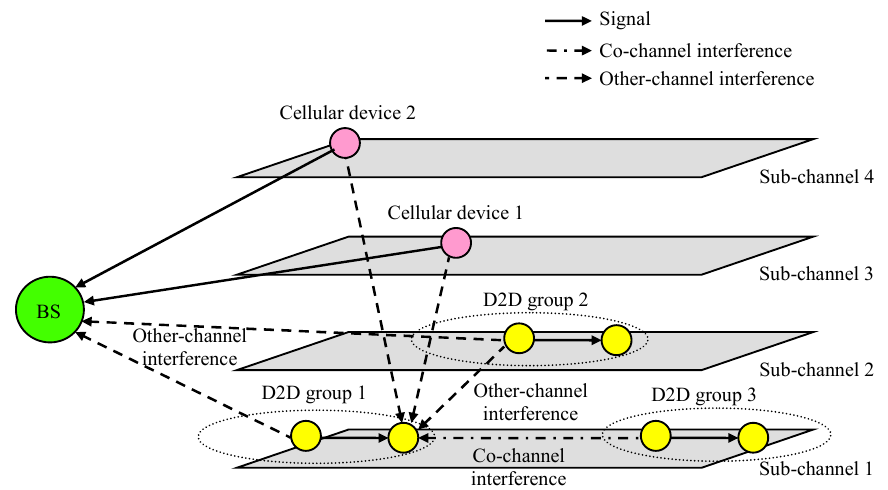
Figure 2. Other-channel interference.